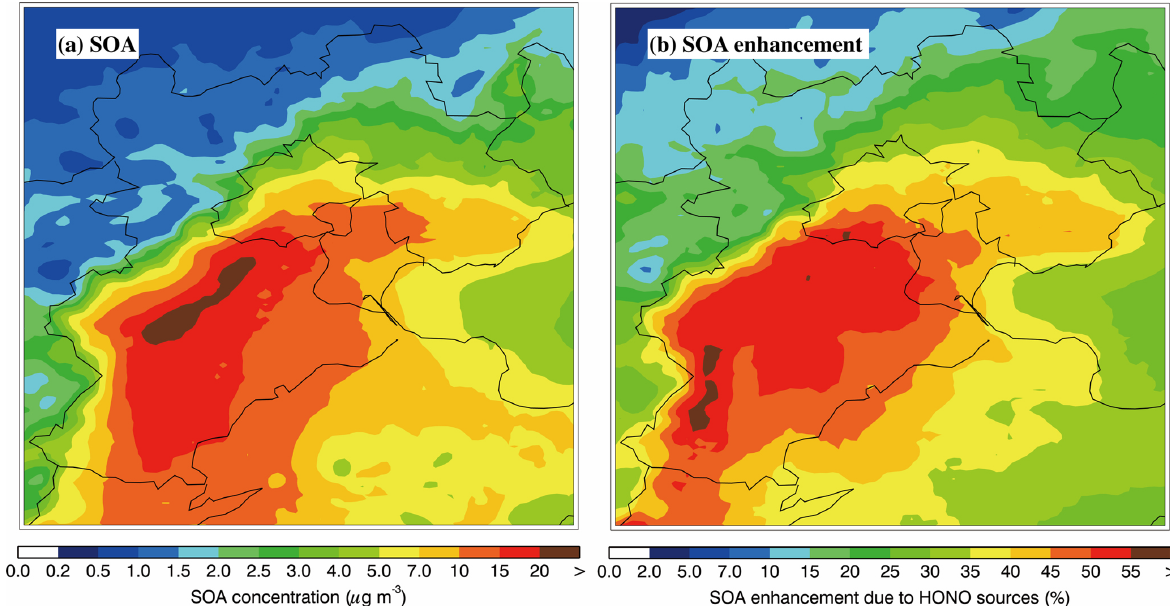
Figure 7. Spatial distribution of (a) the average SOA mass concentration for the BASE case and (b) the percentage SOA enhancement due to the heterogeneous HONO sources during the simulation